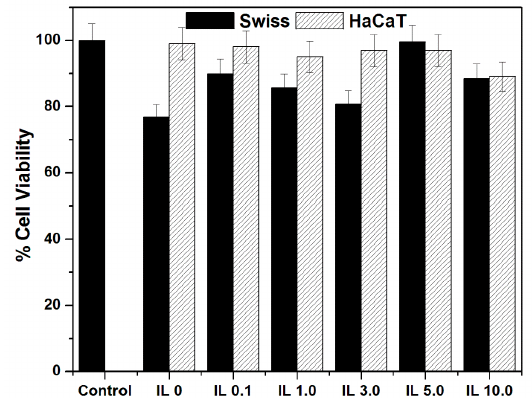
Figure 6. MTT assay of all the gel samples with 1 µg/mL concentration on Swiss and HaCaT cells, respectively.